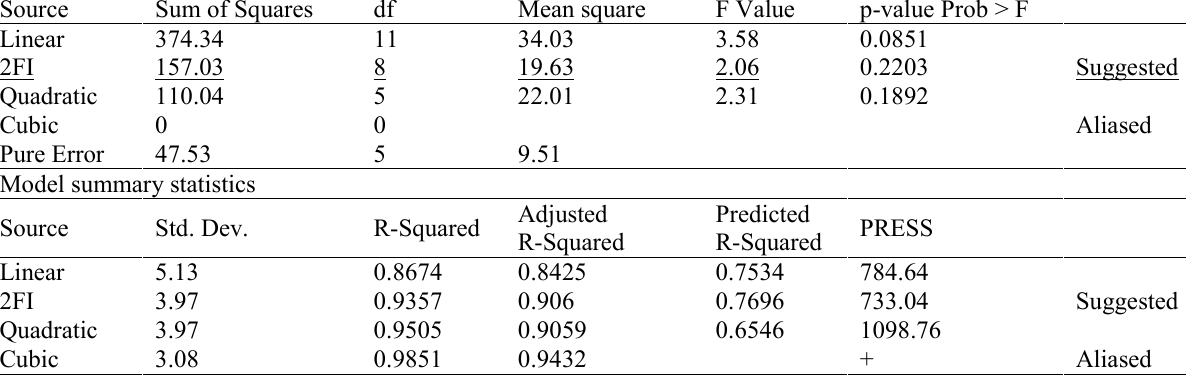
Table 4. Model sum of squares and summary statistics of Cl − ion removal